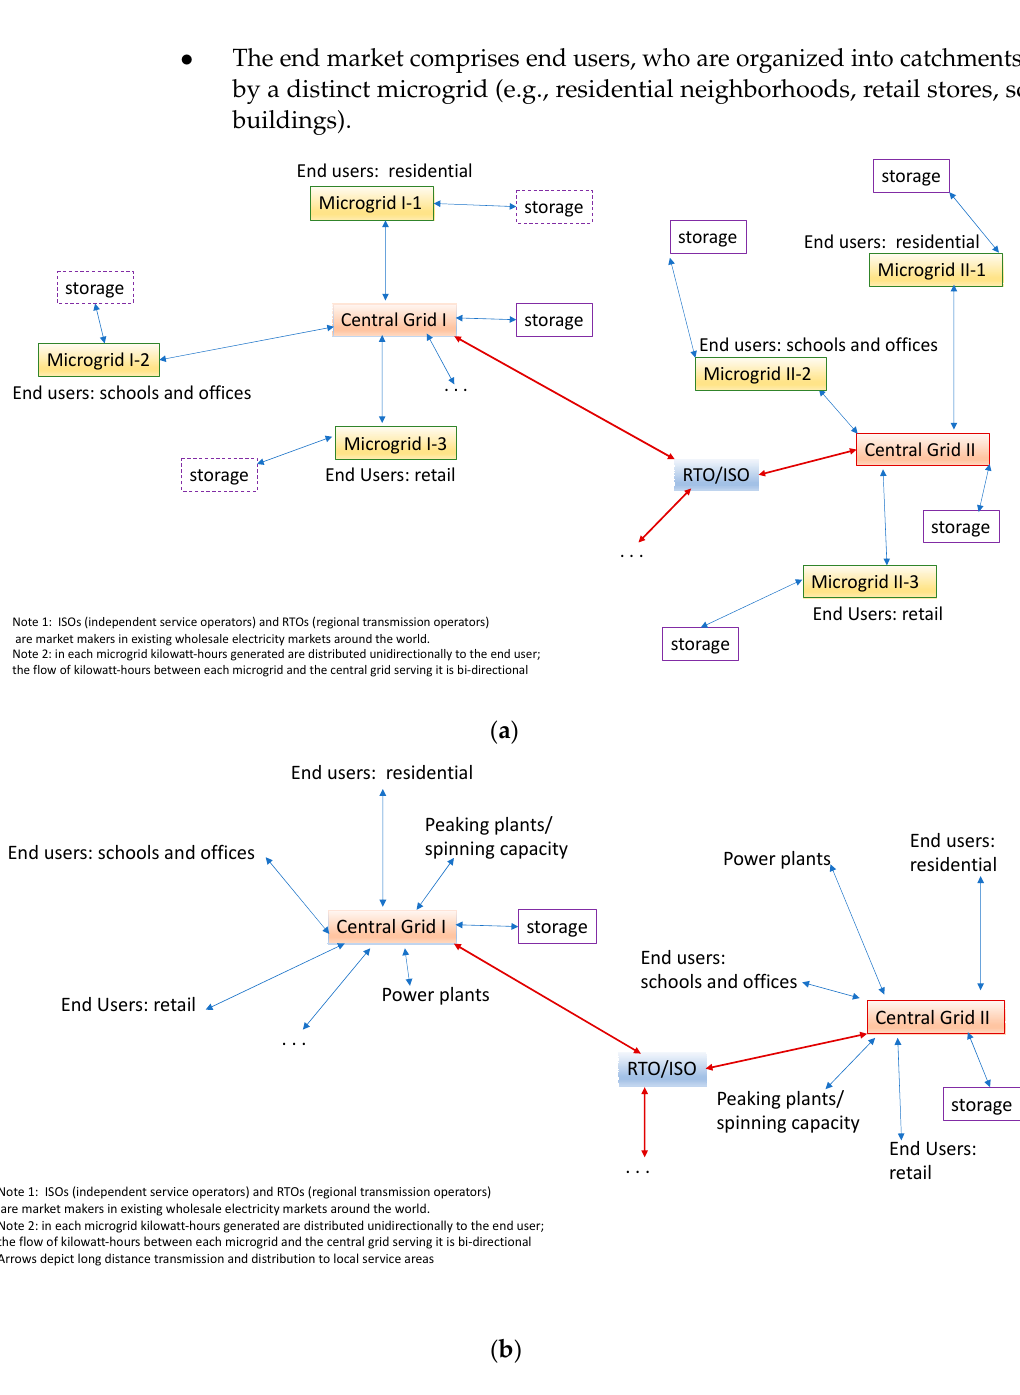
Figure 4. ( a ) The Market System for Electricity Money (hypothetical illustration). ( b ) The Market System Supporting the Conventional Grid.